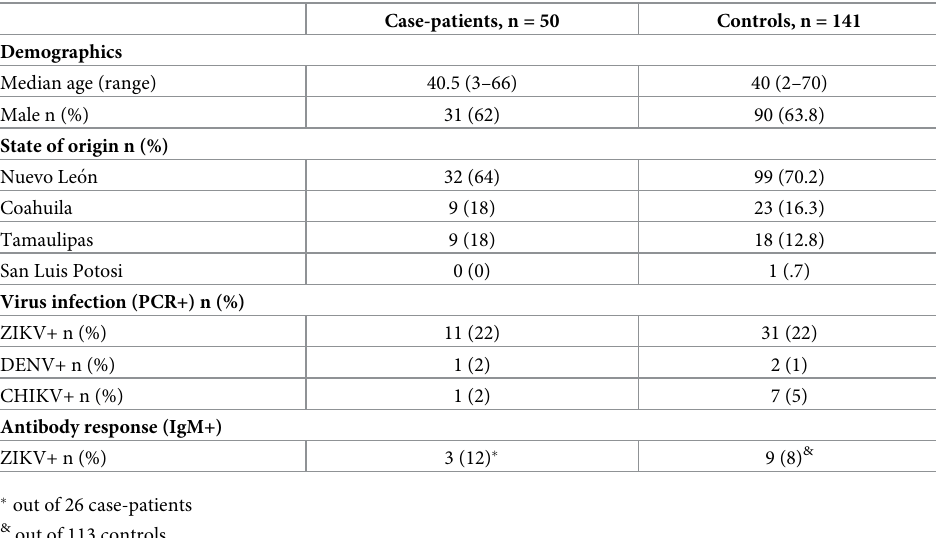
Table 1. Demographics, geographic origin and virus infection.